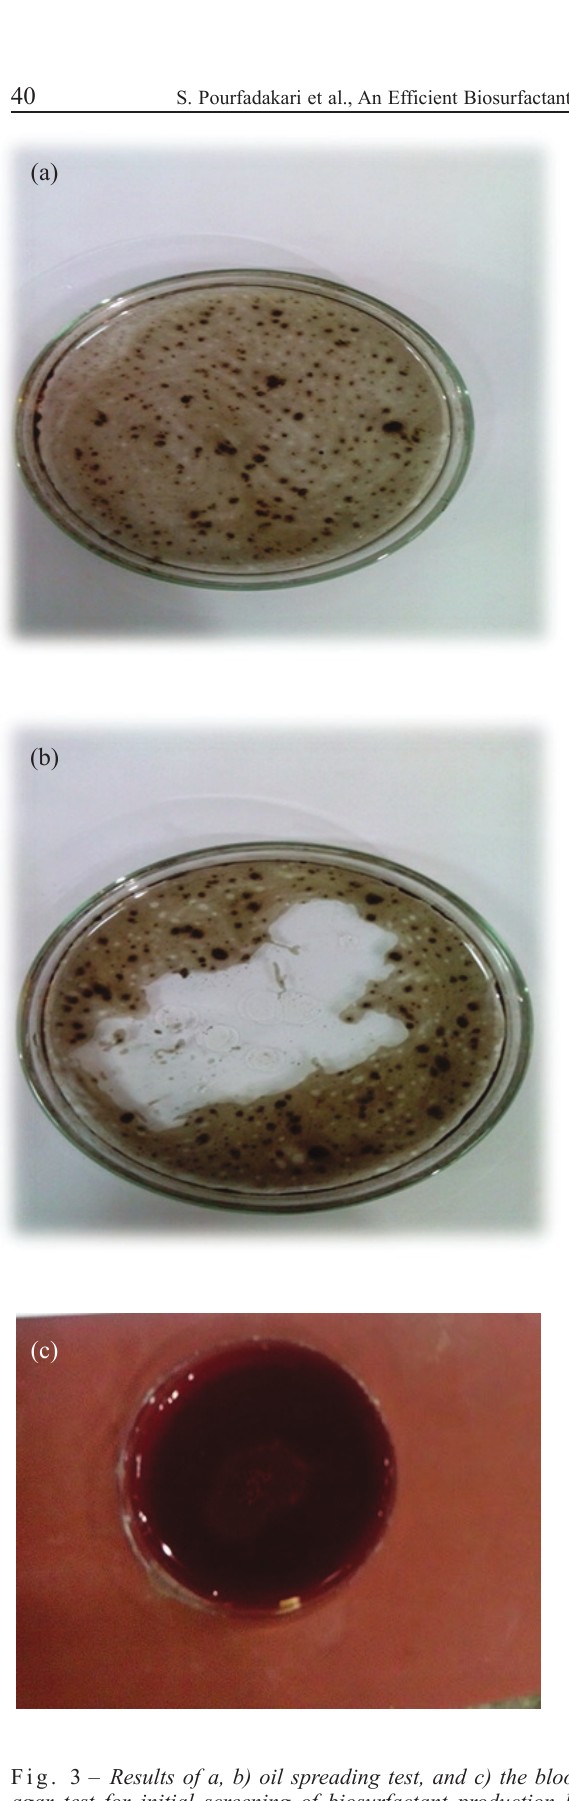
Fig. 4 a) Variations of surface tension (ST) of culture broth versus bacterial growth, b) oil